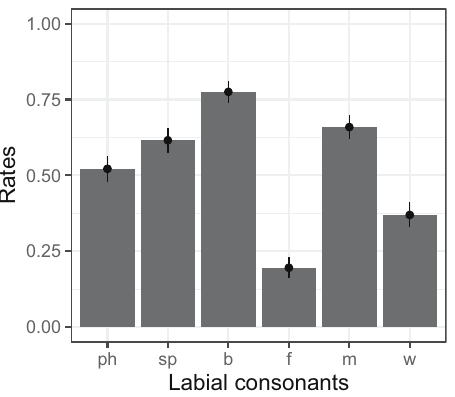
Figure 4: Rates of selecting names with labial consonants for a “ cute ” name ( English )